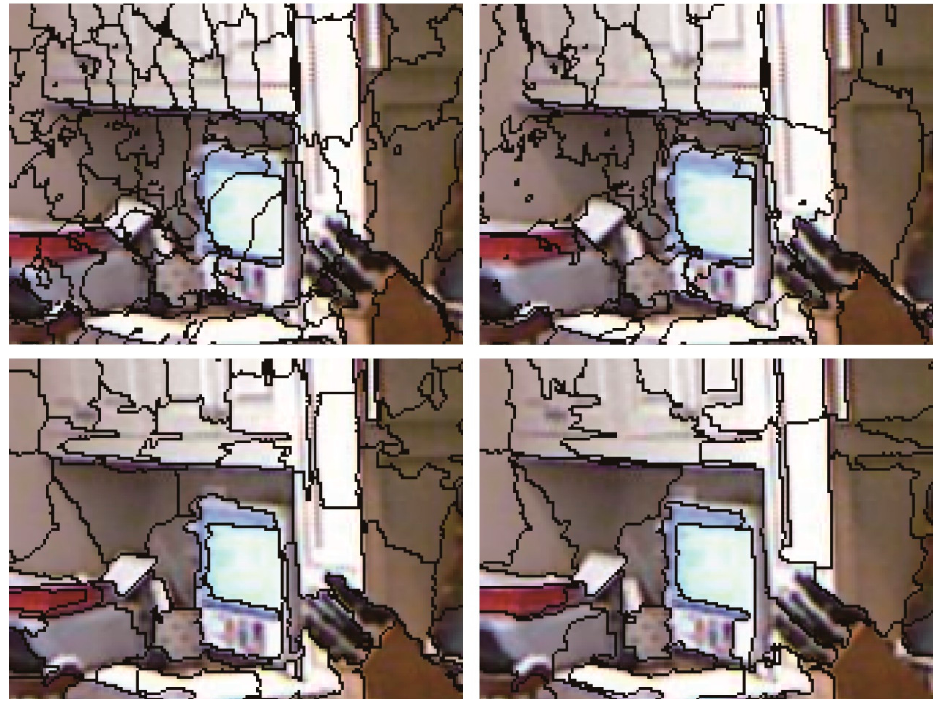
Figure A3. Partially enlarged details of superpixels. From top to bottom are the results of SLIC, DASP, VCCS, and WCFC, respectively. The average superpixel size is approximately 500 pixels in the left column of each image and approximately 300 in the right column.